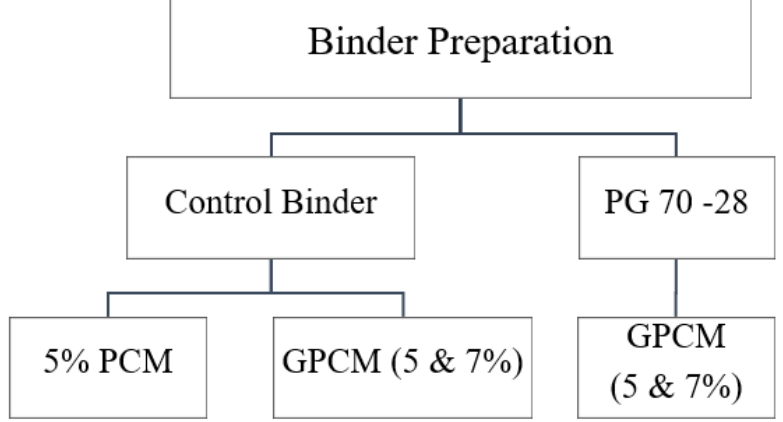
Figure 5. Mixing procedure of GPCM .